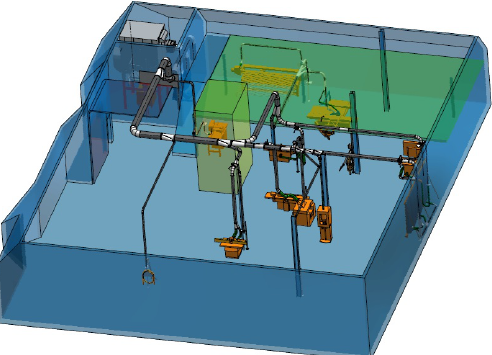
Figure 1. The 3D visual of the wood dust-extraction installation at the MTC.